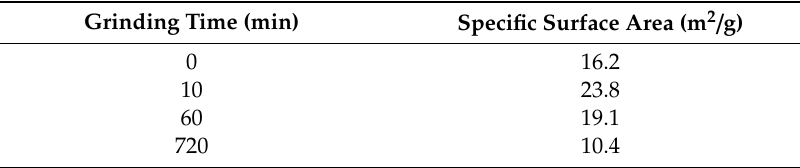
Table 3. Specific surface area of sample with and without grinding [2].